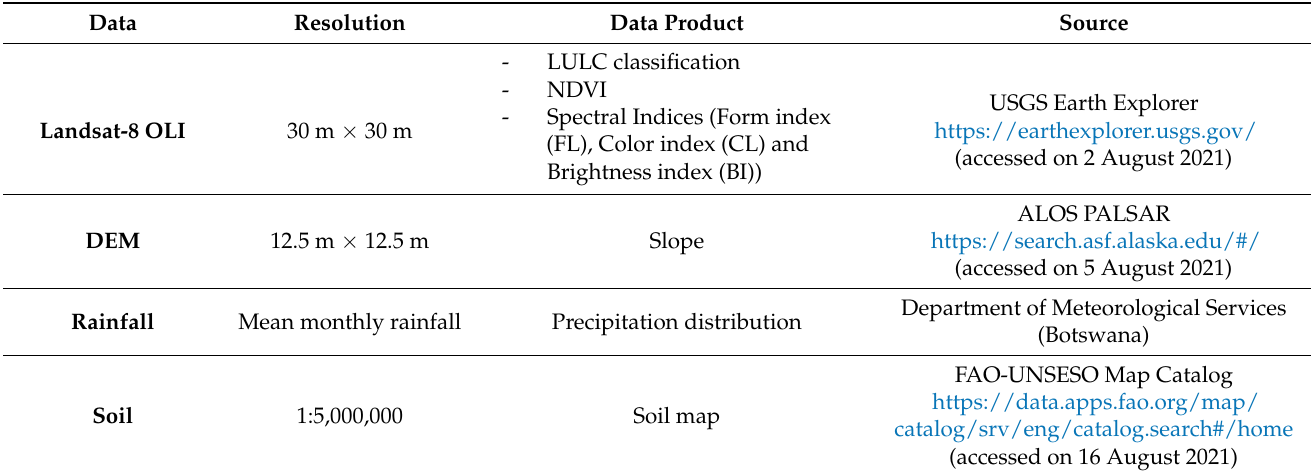
Table 1. Data used in the